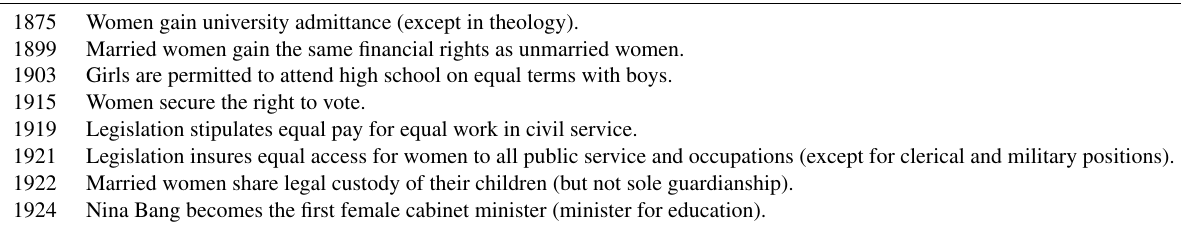
Table 1. Landmarks for women’s rights in Denmark.